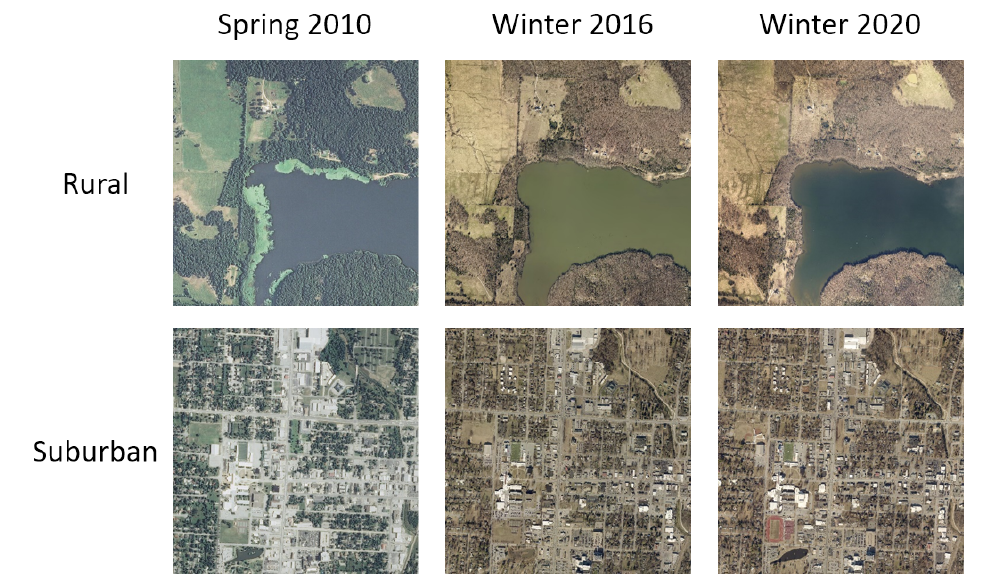
Figure 1. Example images from different data sets, illustrating the visual changes to two locations, one rural and one suburban, over different years and